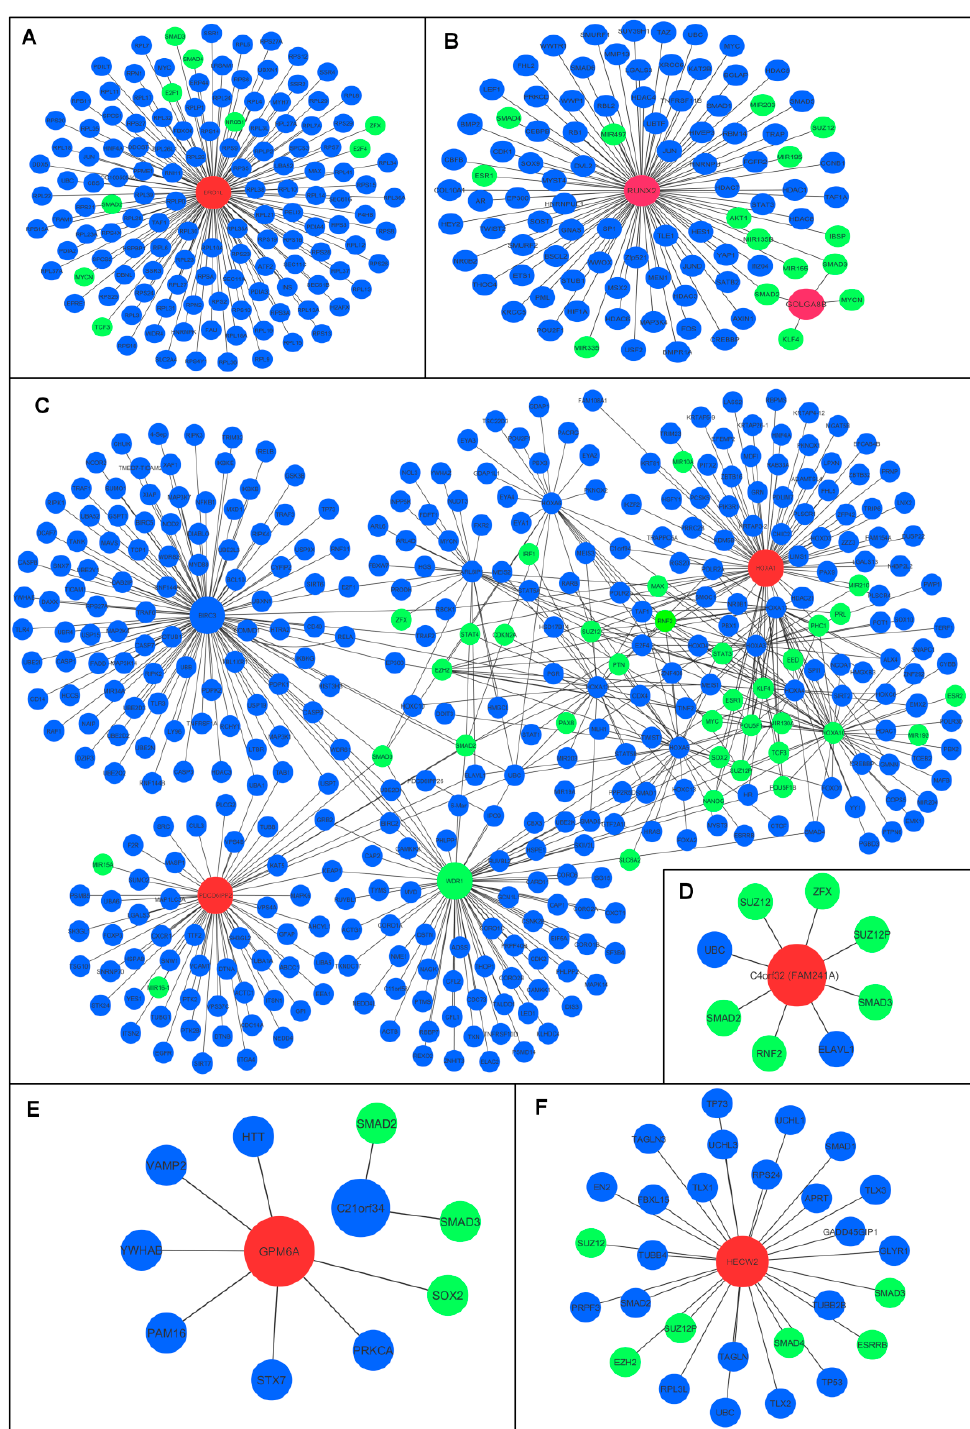
Figure 7. Predicated stemness signatures of selected ceRNA modules. ( A ) ERO1L’s physical and regulatory interactions with stemness-related genes and stemness TFs. ( B ) The interaction of GOLGA8B and RUNX2 partners with the stemness TFs in both the physical and regulatory ways. ( C ) The stemness signature of PDCD6IPP2/miR-23a-3p/HOXA1 module represented via PDCD6IPP2 and HOXA1. ( D ) The stemness signature of ANXA2P1/miR-20b-5p/FAM241A via interaction with stemness- related genes by FAM241A. ( E ) GPM6A interaction with stemness-related genes. ( F ) HECW2 interac- tion with stemness TFs. The red–green color system represents regulatory interaction, the red–blue color system indicates physical